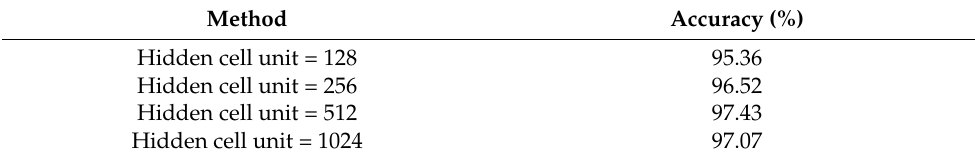
Table 7. Performance of test video clips for LSTM hidden cell unit [26].